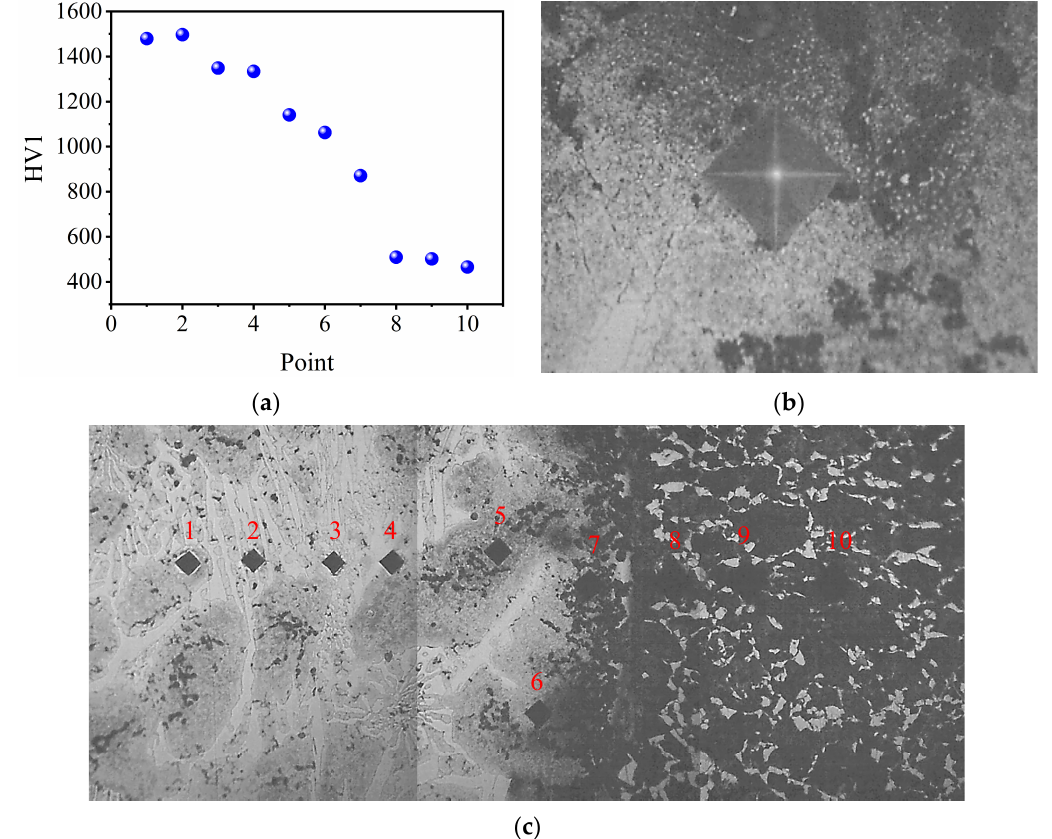
Figure 15. Hardness nearby the interface ( a ), the corresponding indentation of Test Point 6 ( b ), and the locations of all indentations ( c ). The numbers in (c) are the testing order which is a one-to-one correspondence with the point of the abscissa in (a).